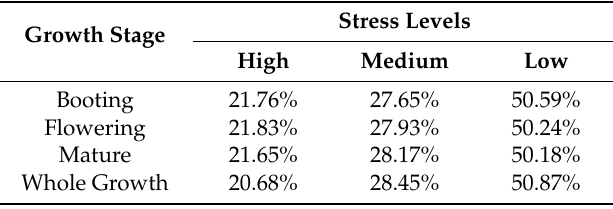
Table 4. Area percentage of rice under different heavy metal stress levels at different growth